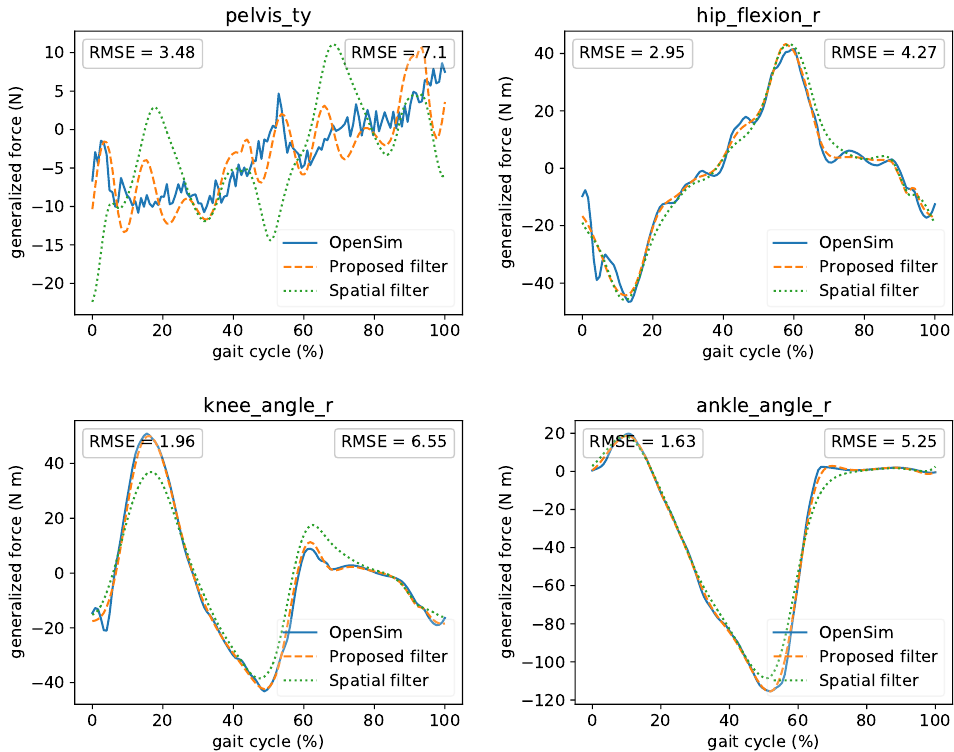
Figure 8. Comparison among offline ID from OpenSim and real-time ID using the two real-time filters. Left RMSE compares OpenSim ’s ID and real-time’s ID that uses the proposed filter. Right RMSE compares OpenSim ’s ID and real-time’s ID that uses the spatial filter. For comparison reasons, the curves were shifted to compensate for the time lag introduced by the